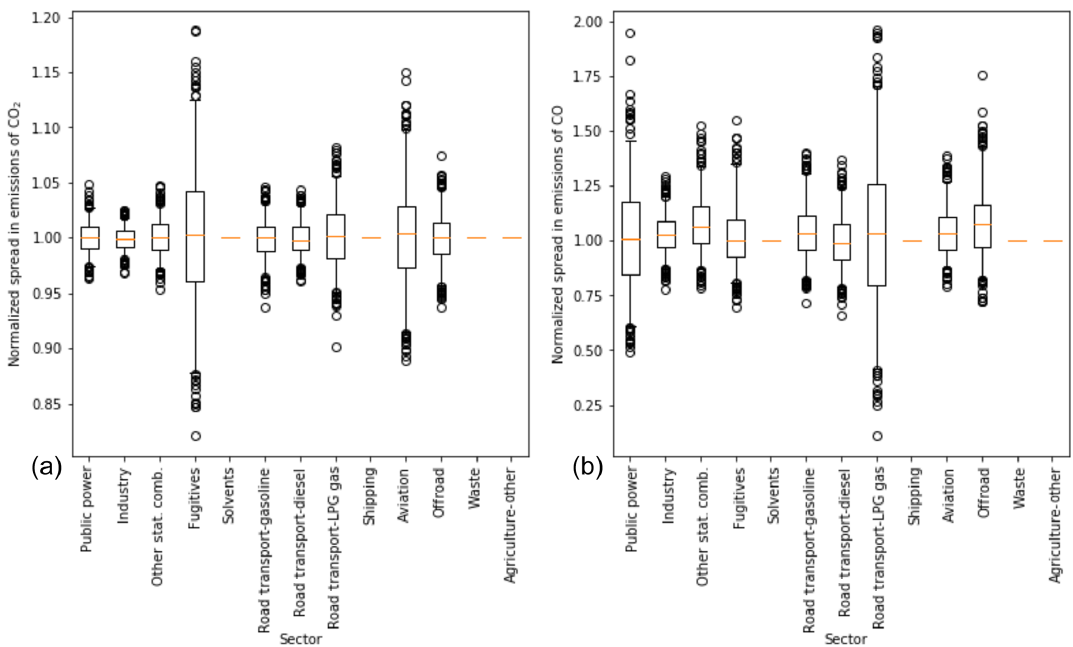
Figure 7. Normalized spread in emissions of CO 2 (a) and CO (b) . The box represents the interquartile range, the whiskers the 2.5–97.5 percentiles, the lines the median values, and the circles are outliers. For sectors where no box is drawn, there are no data included in the Monte Carlo simulation. Note the different scales of the y axis.